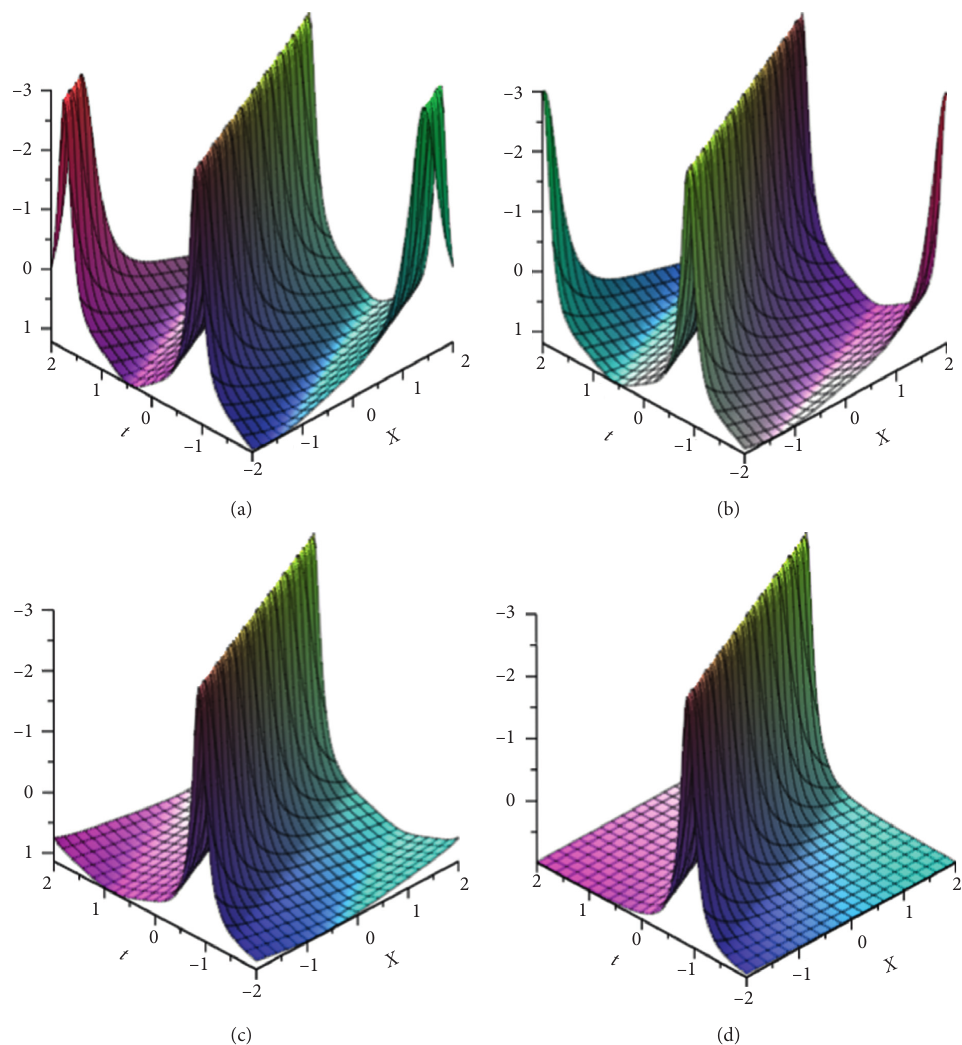
Figure 8: (a) h � 3 . 05 , u −